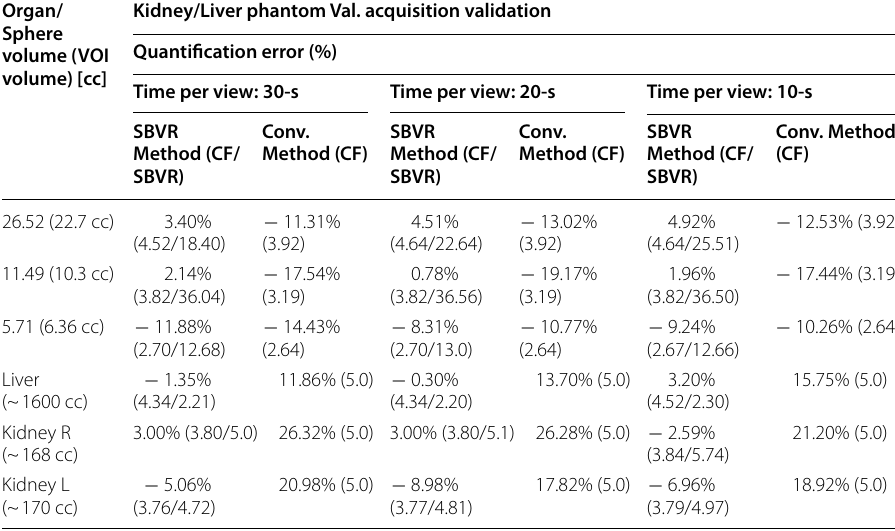
VOI , Volume of interest; CF , Calibration factor [cps/MBq]; and SBVR , Sphere-to-background counts/voxel